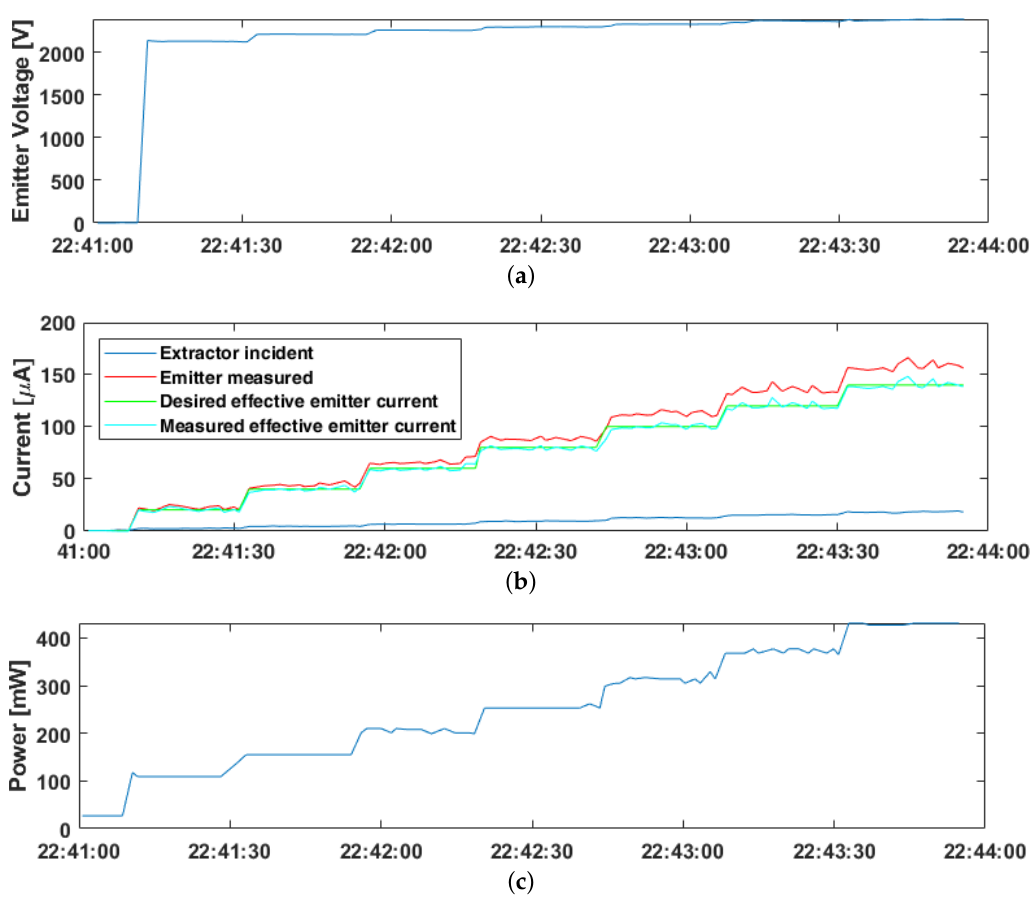
Figure 7. In-orbit characterization of the neutralizer on 28 March 2020. ( a ) Emitter voltage U mon . ( b ) The monitored currents of the PPU. ( c ) Power consumption of the PPU.